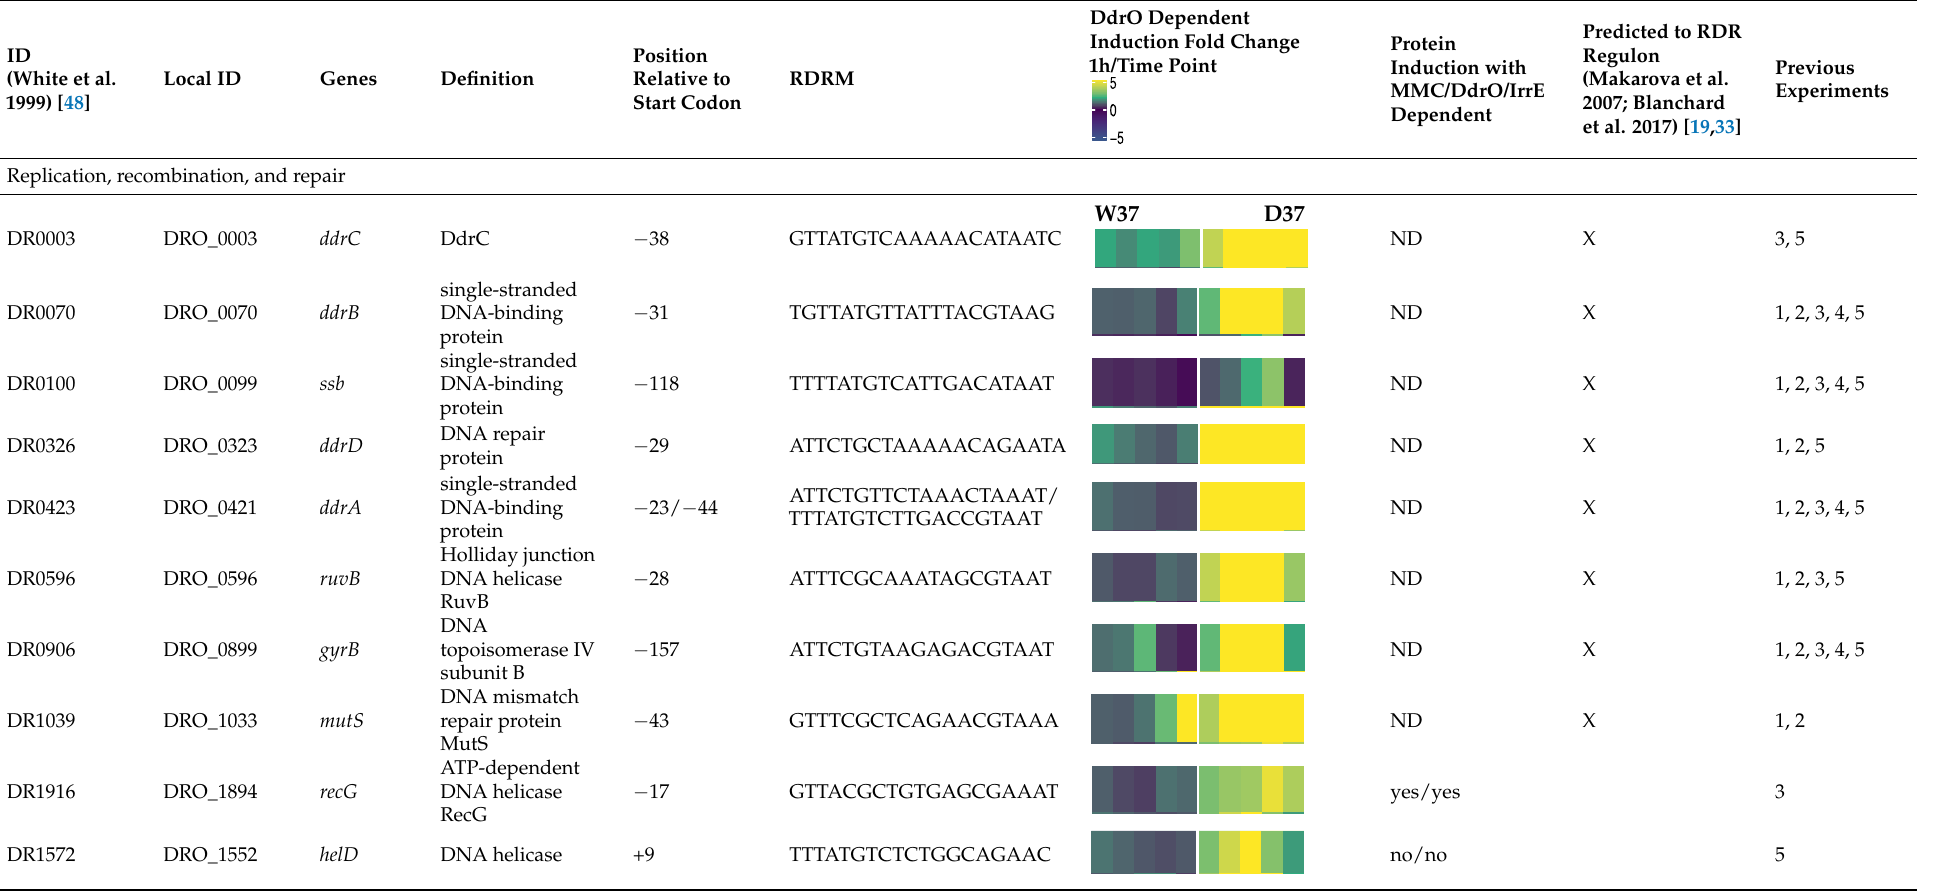
Table 2. List of genes belonging to the DdrO regulon in D. radiodurans matching all criteria (transcriptomic, ChIP-seq, and RDRM). Previous experiments: (1) RDR genes previously predicted by bioinformatic analyses [19,33] (2) by in vitro EMSA assays which analyzed the binding of DdrO to RDRM sequences located in the promoter regions of these genes [26] or shown to be regulated after exposure to radiation by (3) transcriptomic [12], (4) proteomic studies [54], or (5) in a ∆ irrE mutant [24]. Logo of the RDRM consensus performed by MEME from all the RDRM sequences listed in Table 2. ND: Not determined.